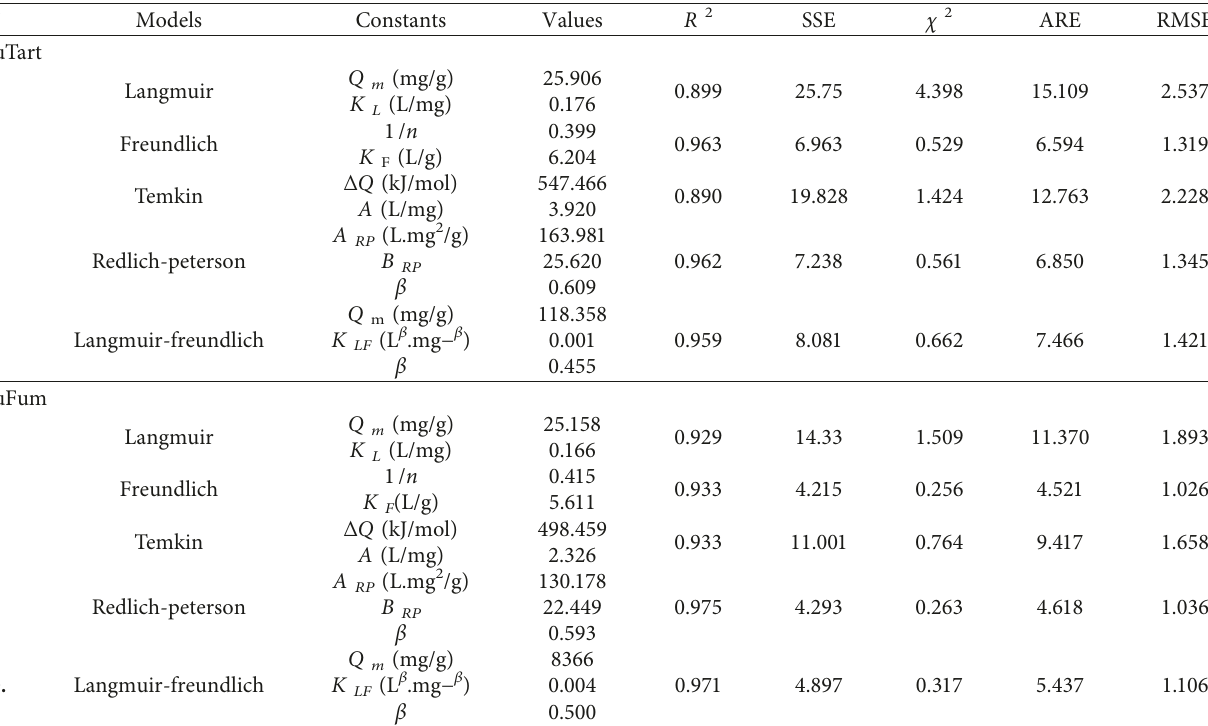
Table 2: Adsorption of phenacetin: non-linear fitting analysis for two and three parameter isotherms. N °